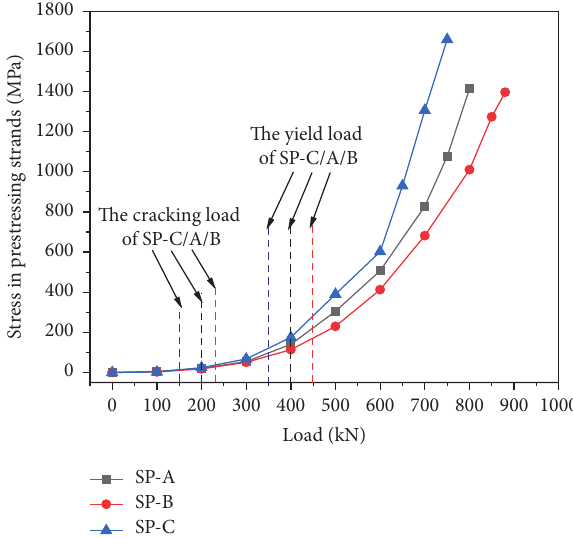
Figure 8: Load-stress curves in prestressing